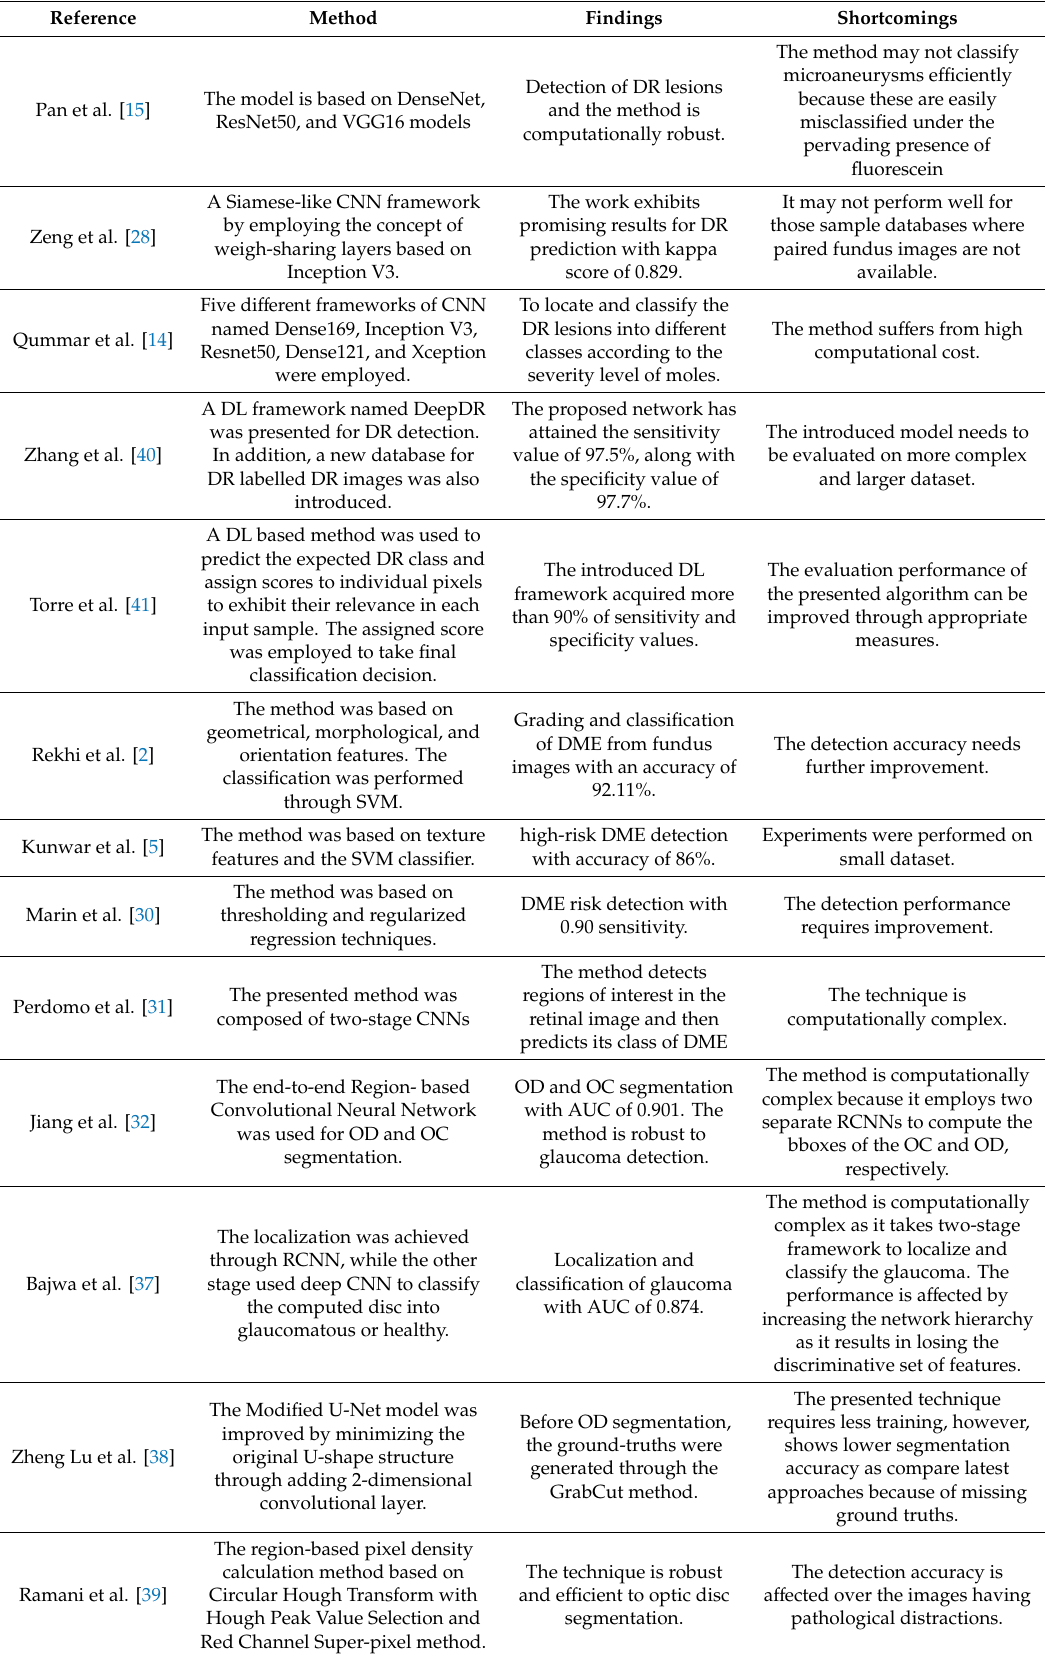
Table 1. A comparison of diabetes-based eye diseases